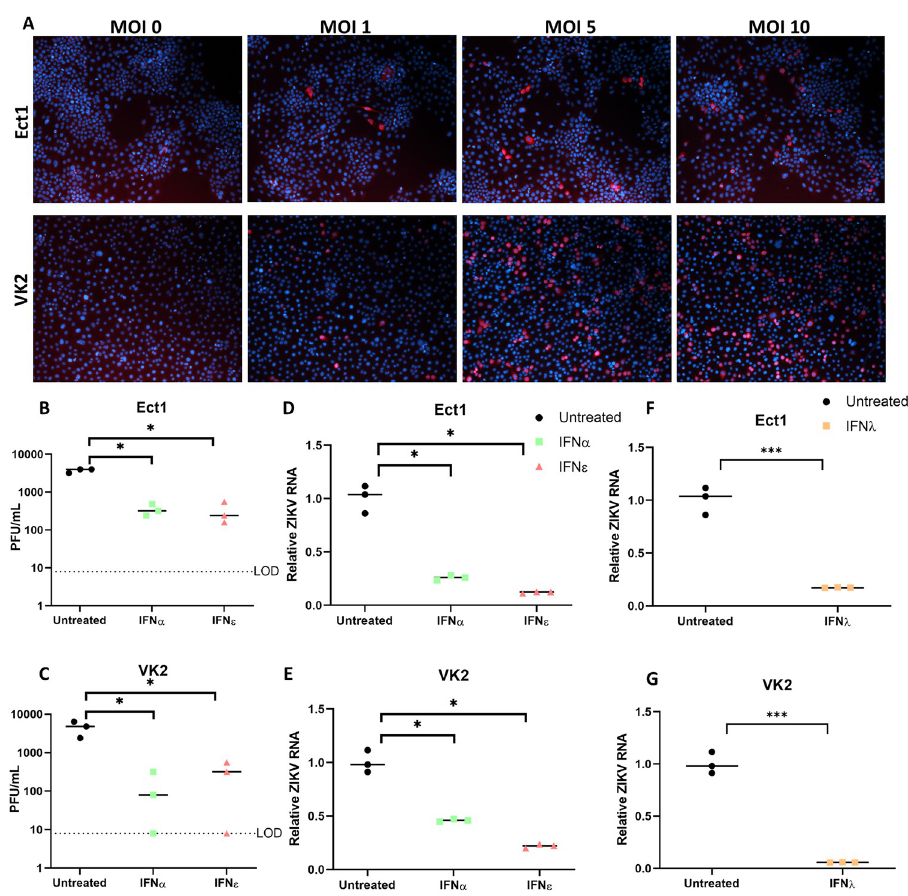
Fig 2. Ectocervical and Vaginal cell lines are permissive to ZIKV infection and treatment with IFN ε is antiviral. A) Ect1 or VK2 cells were infected with ZIKV PRVABC59 at the indicated MOI for 24h prior to staining, anti-flavi E staining (red), DAPI (blue). A-D) Ect1 or VK2 cells were treated overnight (16 hr) with 100 U/mL rhIFN ε , rhIFN α -2A then infected with MOI 10 or 5 respectively for a further 48h prior to collecting supernatant and RNA for plaque assay (B & C) detection of infectious virus or qRT-PCR detection of vRNA (D & E). F-G) Ect1 or VK2 cells were treated overnight with 100 ng/mL rhFN λ -III then infected with MOI 10 or 5 respectively for a further 48h prior to harvesting RNA for detection of vRNA by qRT-PCR. Statistical analyses are performed by Brown-Forsythe and Welch ANOVA and multiple comparisons using a Dunnett’s T test compared to the untreated control (B-E) or by two tailed t-test (F & G), (n.s non-significant, � P < 0.05, �� P < 0.01). Data are presented as means with individual data points representative of independent biological